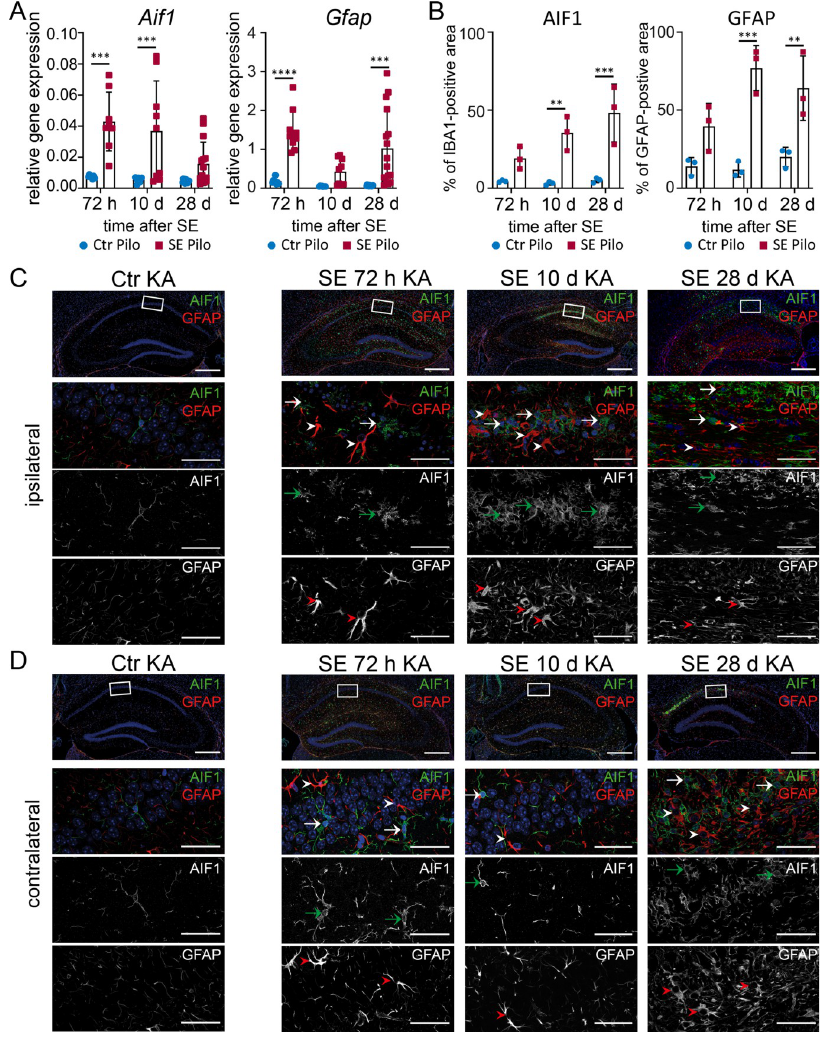
Fig 5. Astrogliosis and microglial activation are persistent after kainic acid-induced SE. (A) mRNA level of Aif1 and Gfap are determined 72 h (n � 4), 10 d (n � 5) and 28 d (n � 6) after SE using the housekeeping gene β -actin ( ΔΔ C t method). (B) Semi-quantitative analysis of AIF1- or GFAP-positive area reveal a progressive increase over time in the ipsilateral CA1 (all groups n = 3). Data is analysed with 2way ANOVA followed by Sidak’s post hoc test. Asterisks indicate significant differences between groups: � p < 0.05, �� p < 0.01, ��� p < 0.001, ���� p < 0.0001. Detailed statistical values are supported in S2 Table. (C) AIF1 (green) positive microglial cells are manifested in the hippocampus post-SE primarily presented with a bushy morphology (arrows) becoming bushier. GFAP positive cells (red) with prominent stem processes are equally scattered over the hippocampal area (arrowheads) mainly found in the CA1 and DG region, with cell processes overlapping to a high degree. In non-SE control animals, a few ramified microglia are observed (leftmost). GFAP positive cells are similarly scarce and presented with very narrow cell processes. Scale bars: 500 μ m (overview), 50 μ m (insert). DAPI for nucleic acid counterstain in